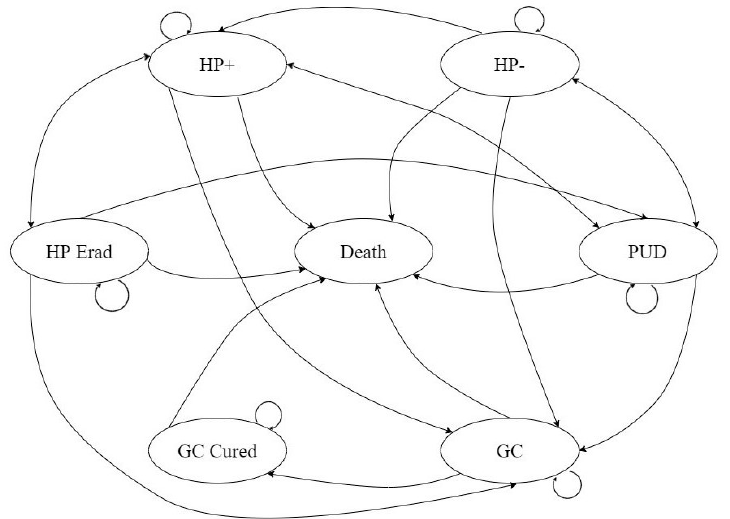
Figure 1. Schematic representation of the Markov model. H. pylori uninfected (HP − ); H. pylori infected (HP+); H. pylori successfully eradicated (HP Erad); gastric cancer (GC); gastric cancer cured (GC Cured); peptic ulcer disease (NUD). At the beginning, all individuals in the cohort entered the model from two healthy states, i.e., HP − and HP+. During each Markovian cycle (1 year), individuals moved between the different health states, the. Table 1. Parameters in the model. PUD, peptic ulcer disease; UBT, urea breath test; NA, not appli- cable; Local data were obtained from reports published by the National Health and Family Plan- ning Commission of China or the State Food and Drug Administration of China.